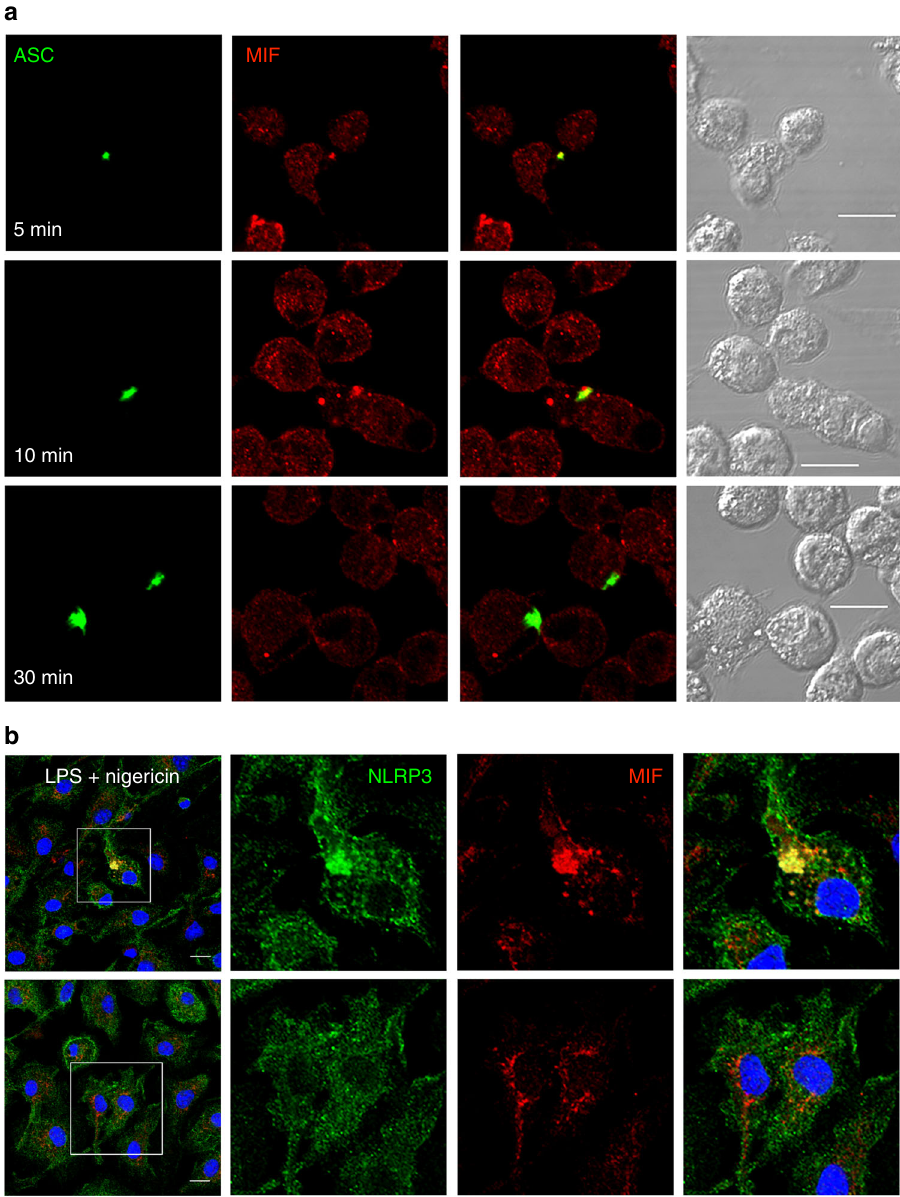
Fig. 7 MIF co-localizes with the NLRP3 in fl ammasome. a ASC-cerulean macrophages were primed with LPS (10 ng ml − 1 ) overnight. The following day cells were treated with nigericin (10 µ M) for the indicated times. Co-localization of ASC (green) and MIF (red) were visualized using confocal microscopy. Confocal images are representative of at least three independent experiments. b Primary murine BMDMs were treated with LPS (10 ng ml − 1 ) overnight, and then treated with or without COR123625 (50 µ M), followed by nigericin (5 µ M) for 20 min. Cells were fi xed and stained with antibodies against NLRP3 and MIF. Nuclei were stained with DAPI. All scale bars = 10 μ